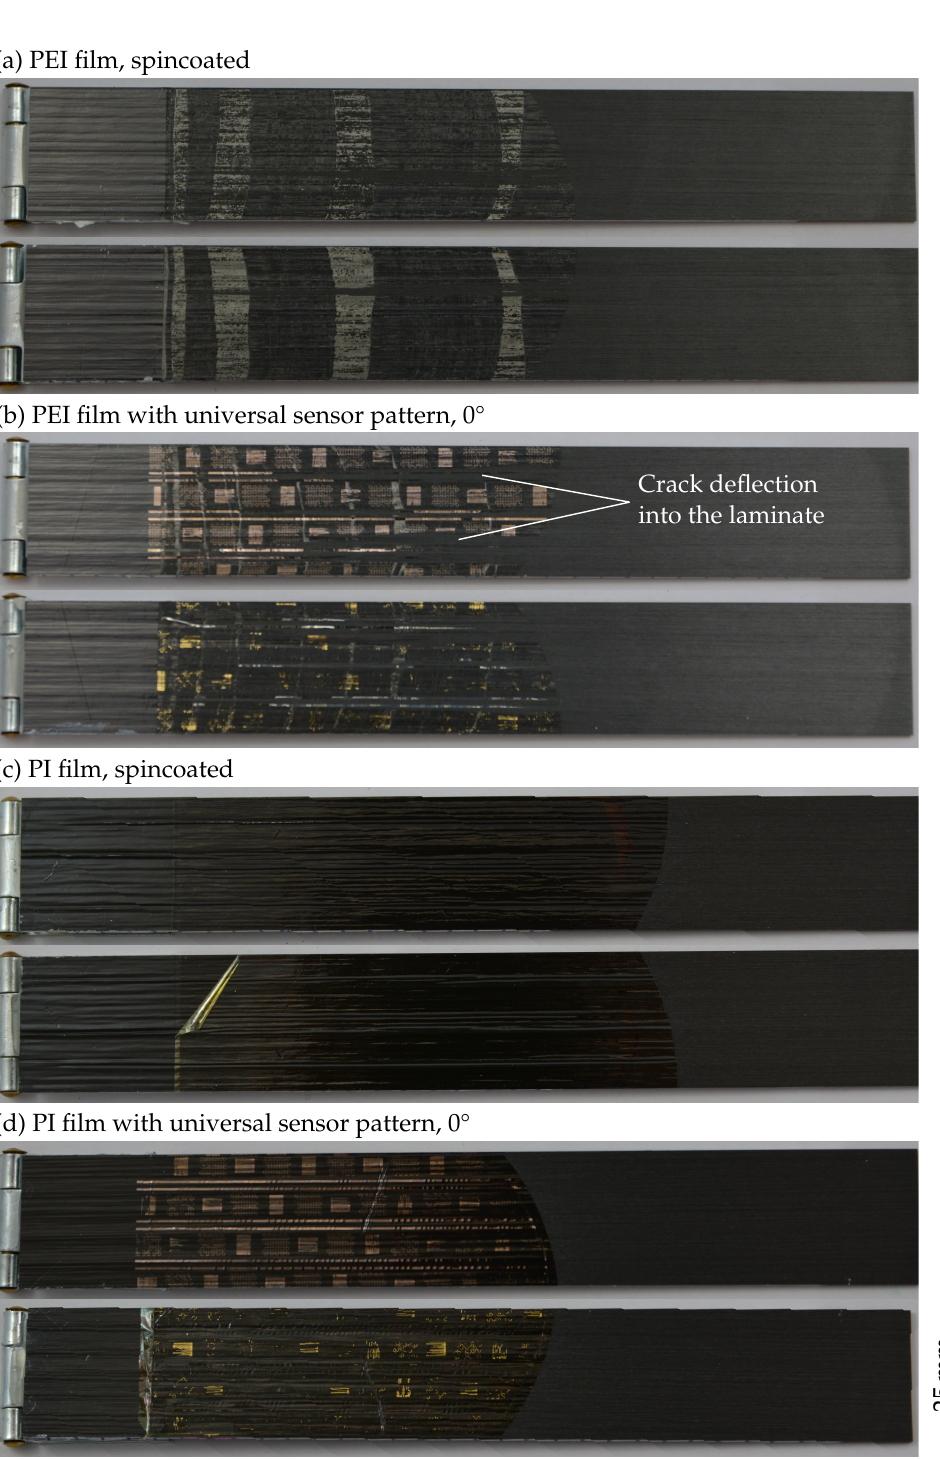
Figure 12. Fracture surfaces of DCB specimens: ( a ) PEI film, spin coated, without sensor pattern. ( b ) PEI film, with 0° sensor pattern. ( c ) PI film, spin coated, without sensor pattern. ( d ) PI film, spin coated, with 0° sensor